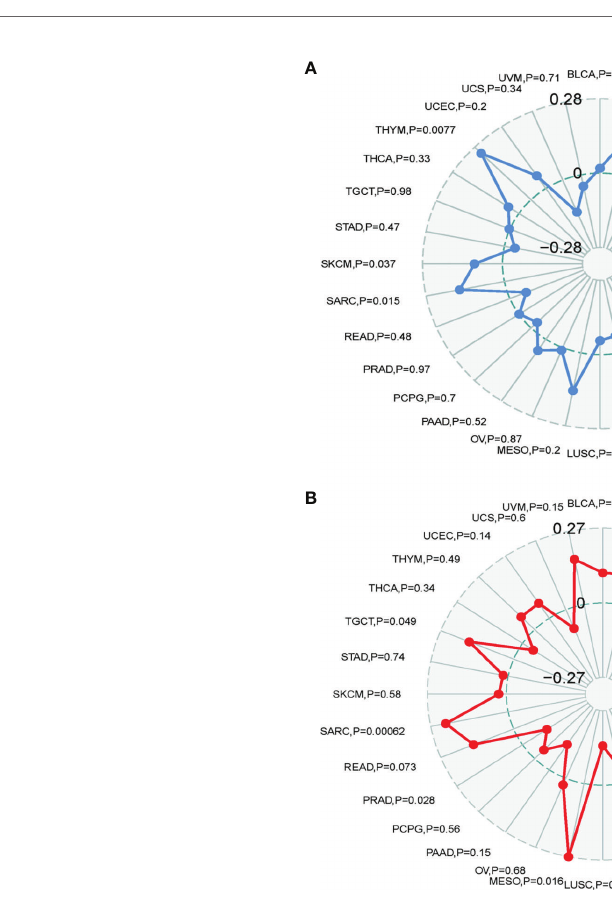
FIGURE 9 | Correlation between TRMP8 and TMB and MSI. (A) TRPM8 correlation with TMB. (B) TRPM8 correlation with